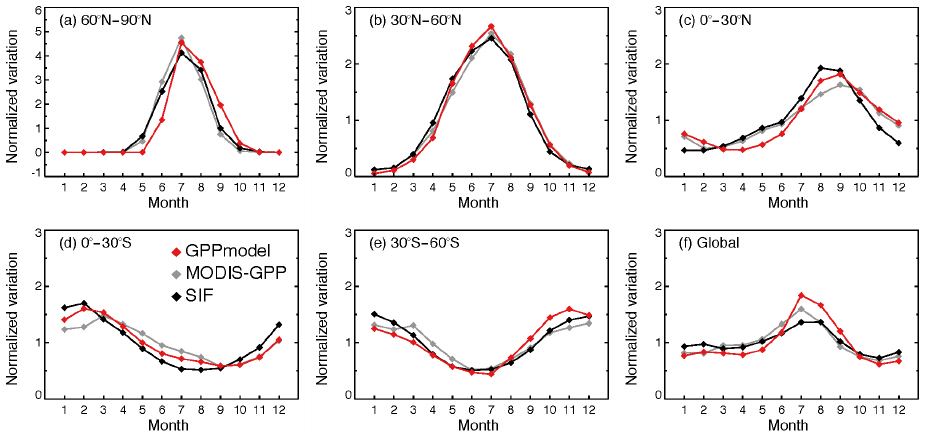
Figure 10. The normalized seasonal variation of modelled GPP (GPP model ) , MODIS-GPP, and SIF for five latitude bands (a–e) and (f) global